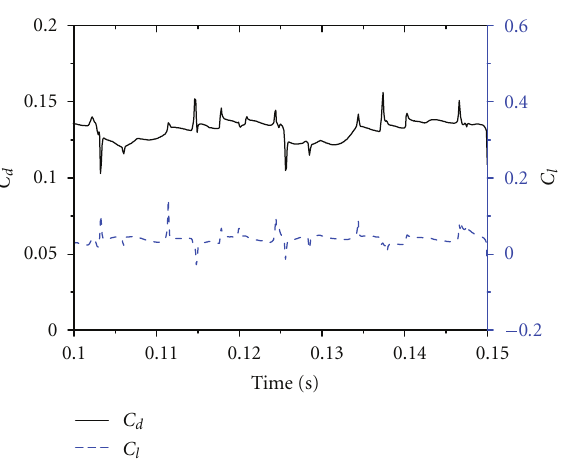
Figure 16: Variation of C d and C l along with σ v , h/H = 0 . 50, σ v = 0 . 507, transition type cavity.